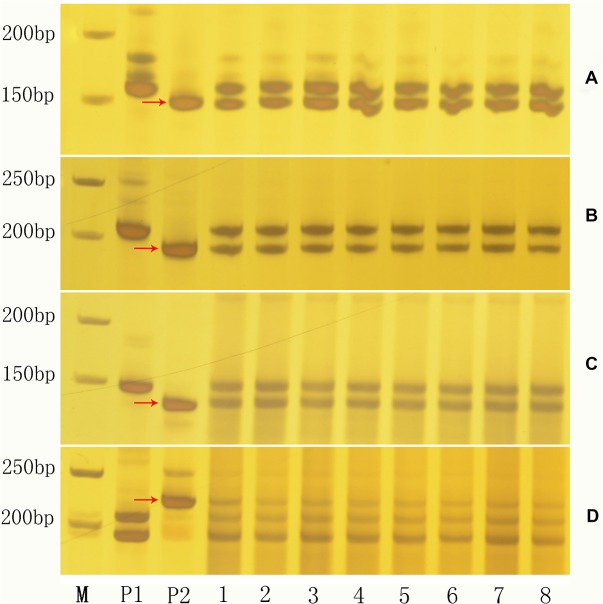
Validation of putative hybrids of G. hirsutum × G. arboreum using a randomly selected set of G. arboreum-specific SSR primers.From A to D, G. arboreum-specific amplicons (arrows) were detected using individual chromosome-specific SSR primers NAU70, NAU299, NAU740 and NAU815, respectively. P1, G. hirsutum; P2, G. arboreum; 1–8 show F1 plants of G. hirsutum × G. arboreum; M, molecular marker sizes (50 bp ladder).